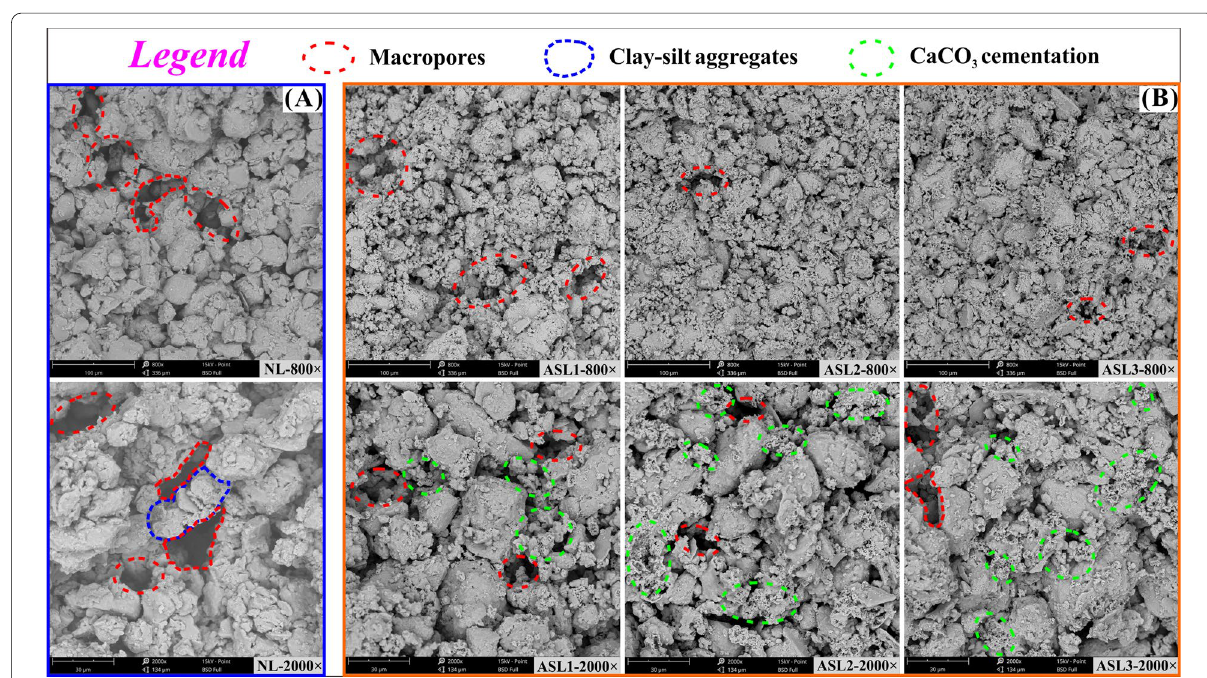
Fig. 4 Representative SEM images of the A NL and B ASL samples